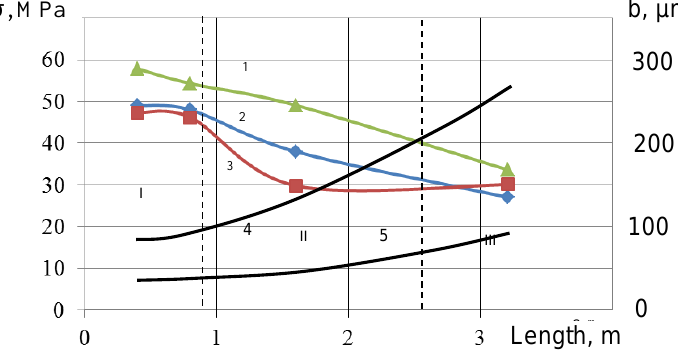
Fig.4 The dependences of bending strength and depth of critical micro-cracks on the length of standing specimens: 1 - the mean values of bending strength; 2 - the minimum values of bending strength for bi-modal Weibull curves; 3 - the minimum values of bending of bending strength for uni-modal Weibull curves (3); 4 - depth of semicircular cracks; 5 - depth of long semielliptical